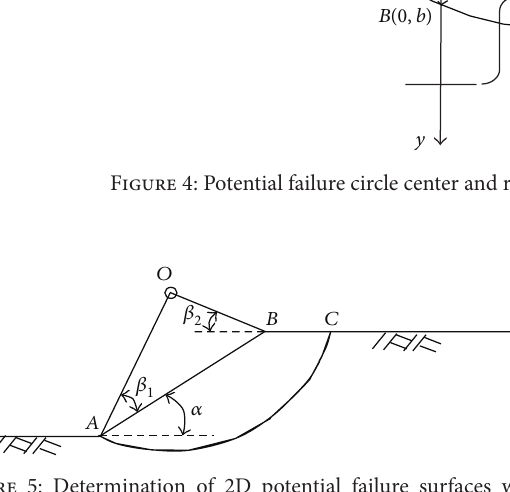
Figure 5: Determination of 2D potential failure surfaces when internal friction angle 𝜑 = 0 .